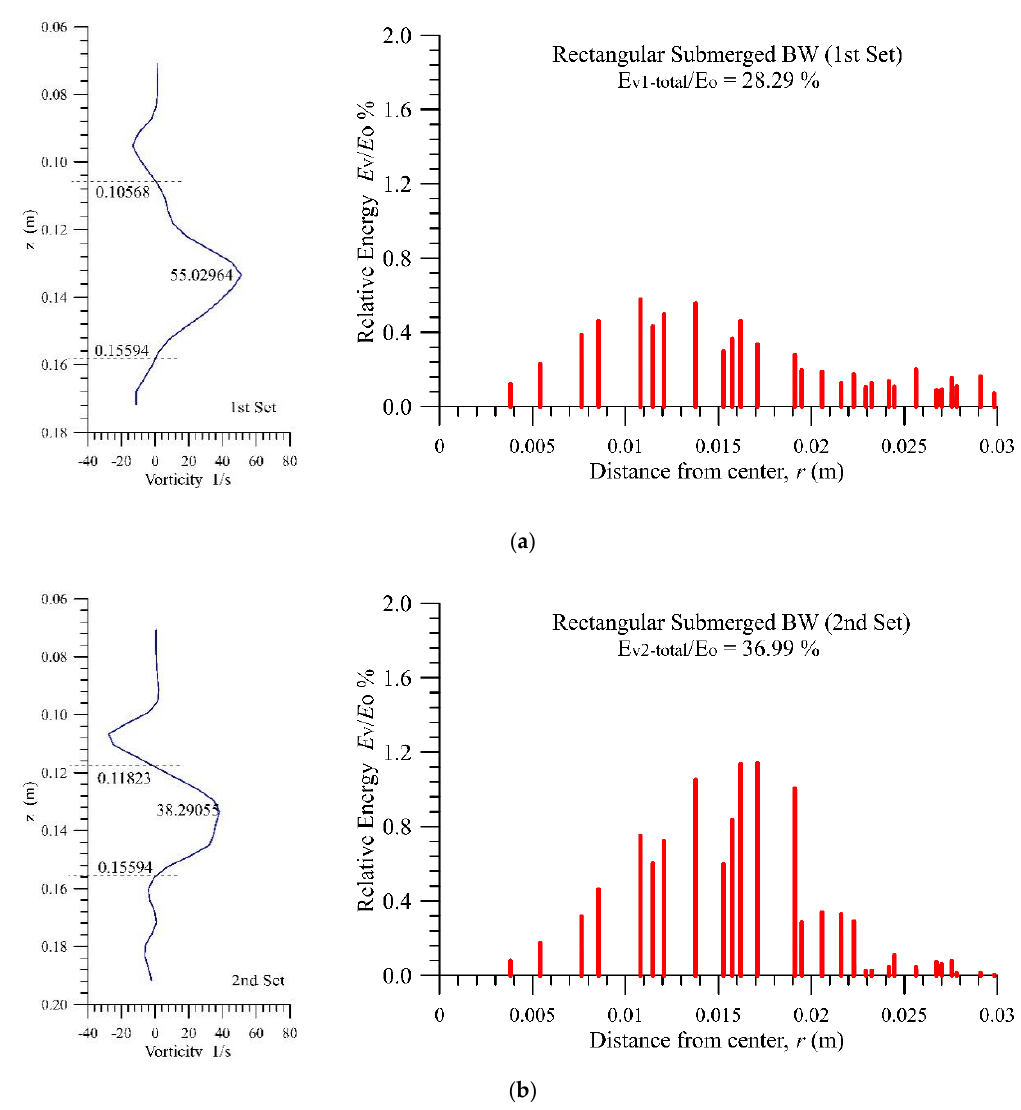
Figure 13. The vorticity distribution along the vertical line of the vortex center, and the relative vortex energy distribution of the maximum vortex induced by a solitary-like wave propagating over ( a ) the first set and ( b ) the second set of a composite set of rectangular submerged breakwaters.